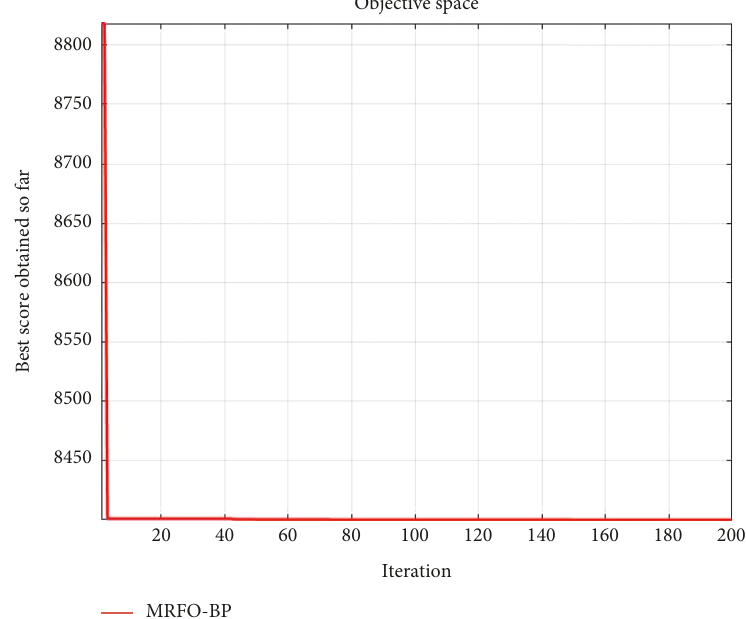
Figure 11: Historical optimal position curve of the middle of the spiral casing.